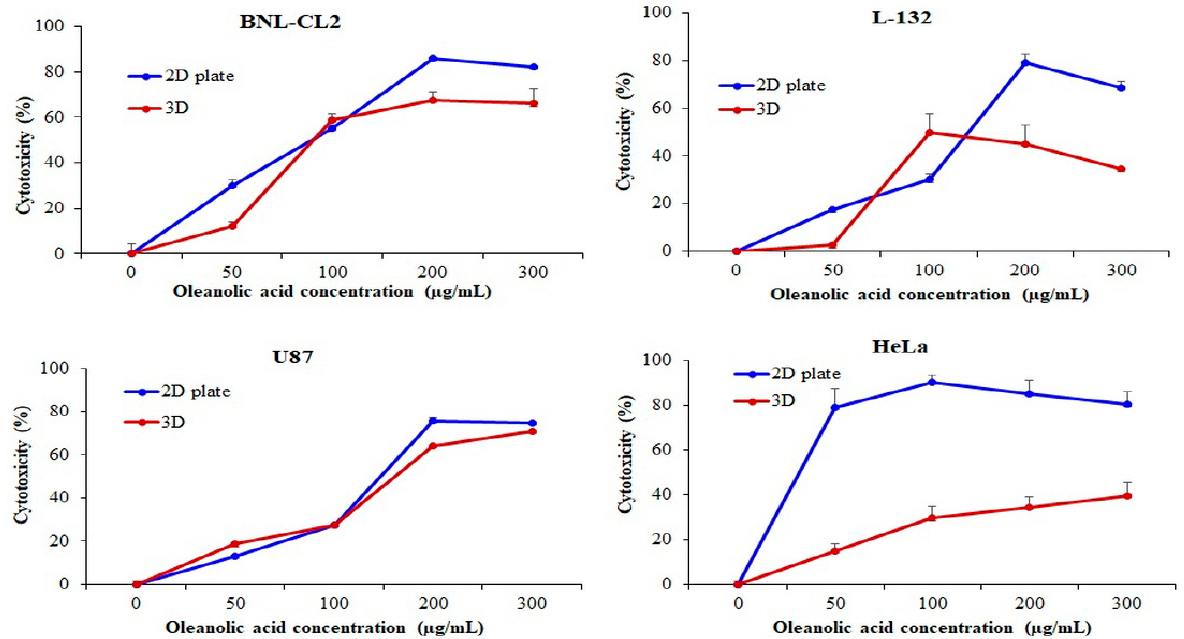
Figure 6. Cytotoxicity evaluation of normal cell lines (BNL-CL2 and L-132) and cancer cell lines (U87 and HeLa) cultured in a two-dimensional (2D) plate and polydimethylsiloxane (PDMS) multi-channel cell chip using the lactate dehydrogenase (LDH) assay. The cells were cultured at 1 × 10 5 cells/mL and treated with oleanolic acid (OA; 50, 100, 200, 300 µg/mL) for 24 h. The relative cell viability was calculated as the percentage of untreated cells. The data are represented as mean ± SD, n = 3.